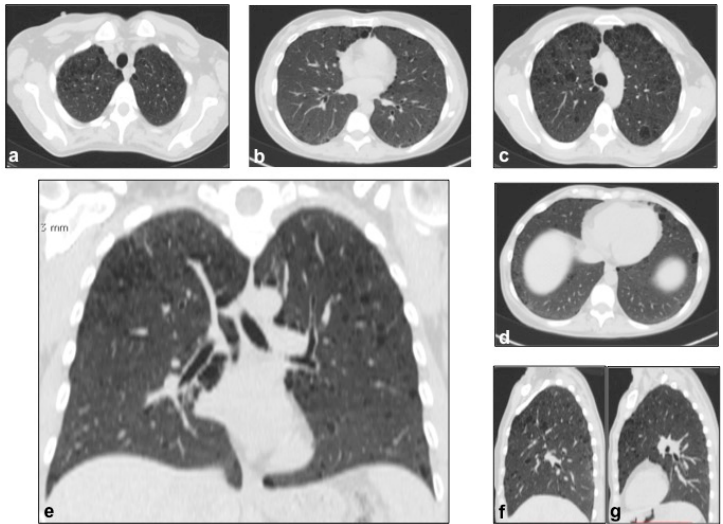
Figure 12. In NF1, the cysts usually present no clearly-defined walls. These lesions are predominant in the superior regions ( a , b ). Detail of NF1 cysts ( b ).